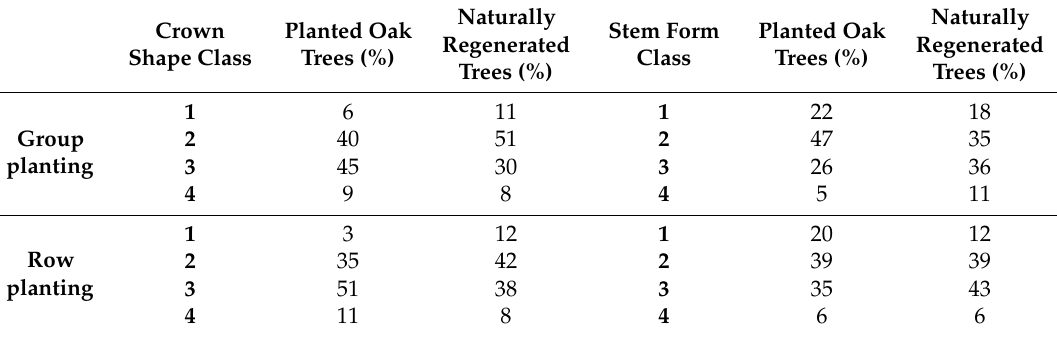
Table 4. Crown shape and stem form of planted oaks and naturally regenerated trees in group and regenerated trees × planting type = 0.070, p > row planting ( n = five pairs of group and row planting stands). Cramér’s V values: crown shape of